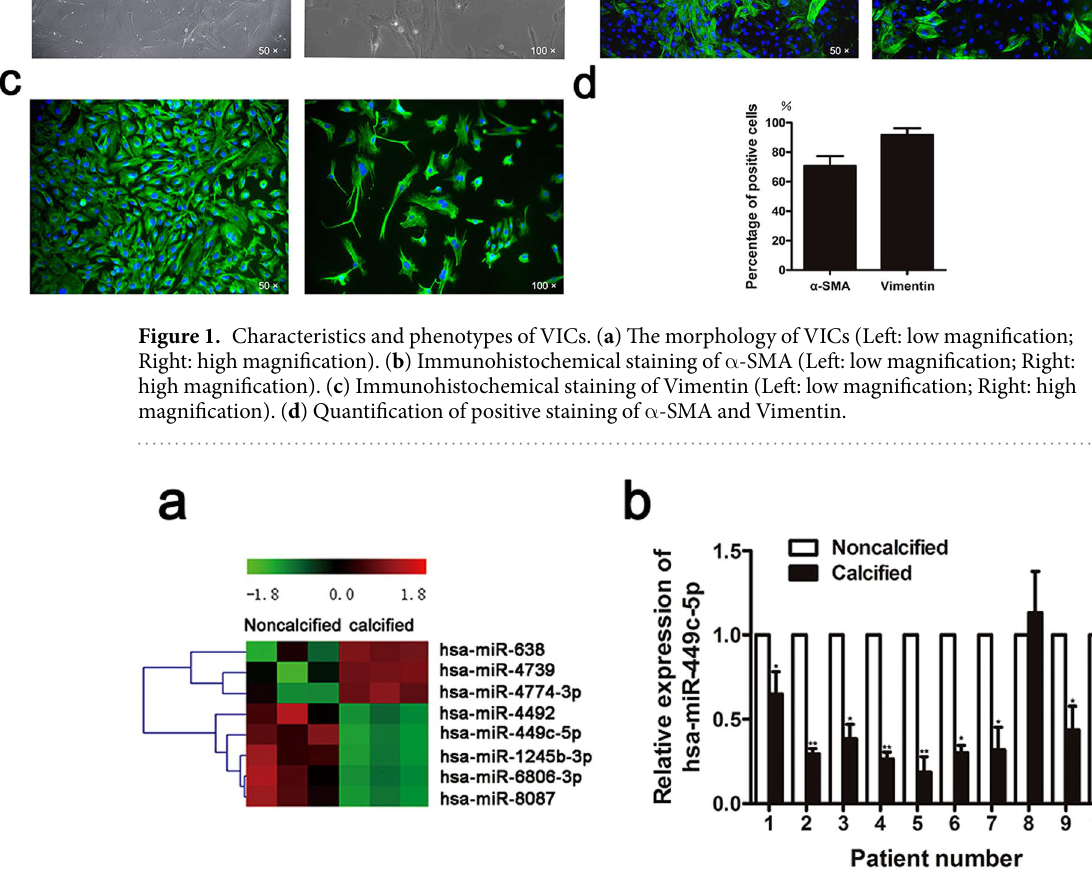
Figure 2. MiR-449c-5p is downregulated in human calcific aortic valves. ( a ) Heat map based on the differential expression of miRNAs between non-calcific and calcific aortic valves calculated by microarray. n = 3 in each group. ( b ) Verification of miR-449c-5p expression by qRT-PCR in non-calcific and calcific valves from 10 CAVD patients. Data are presented as the mean ± SD. * P < 0.05, ** P <